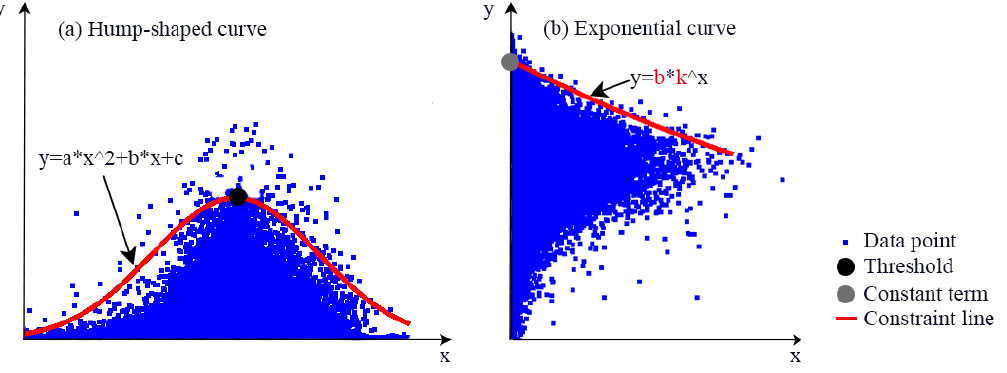
Figure 4. Extraction of constraint lines using the segmented quantile regression approach.